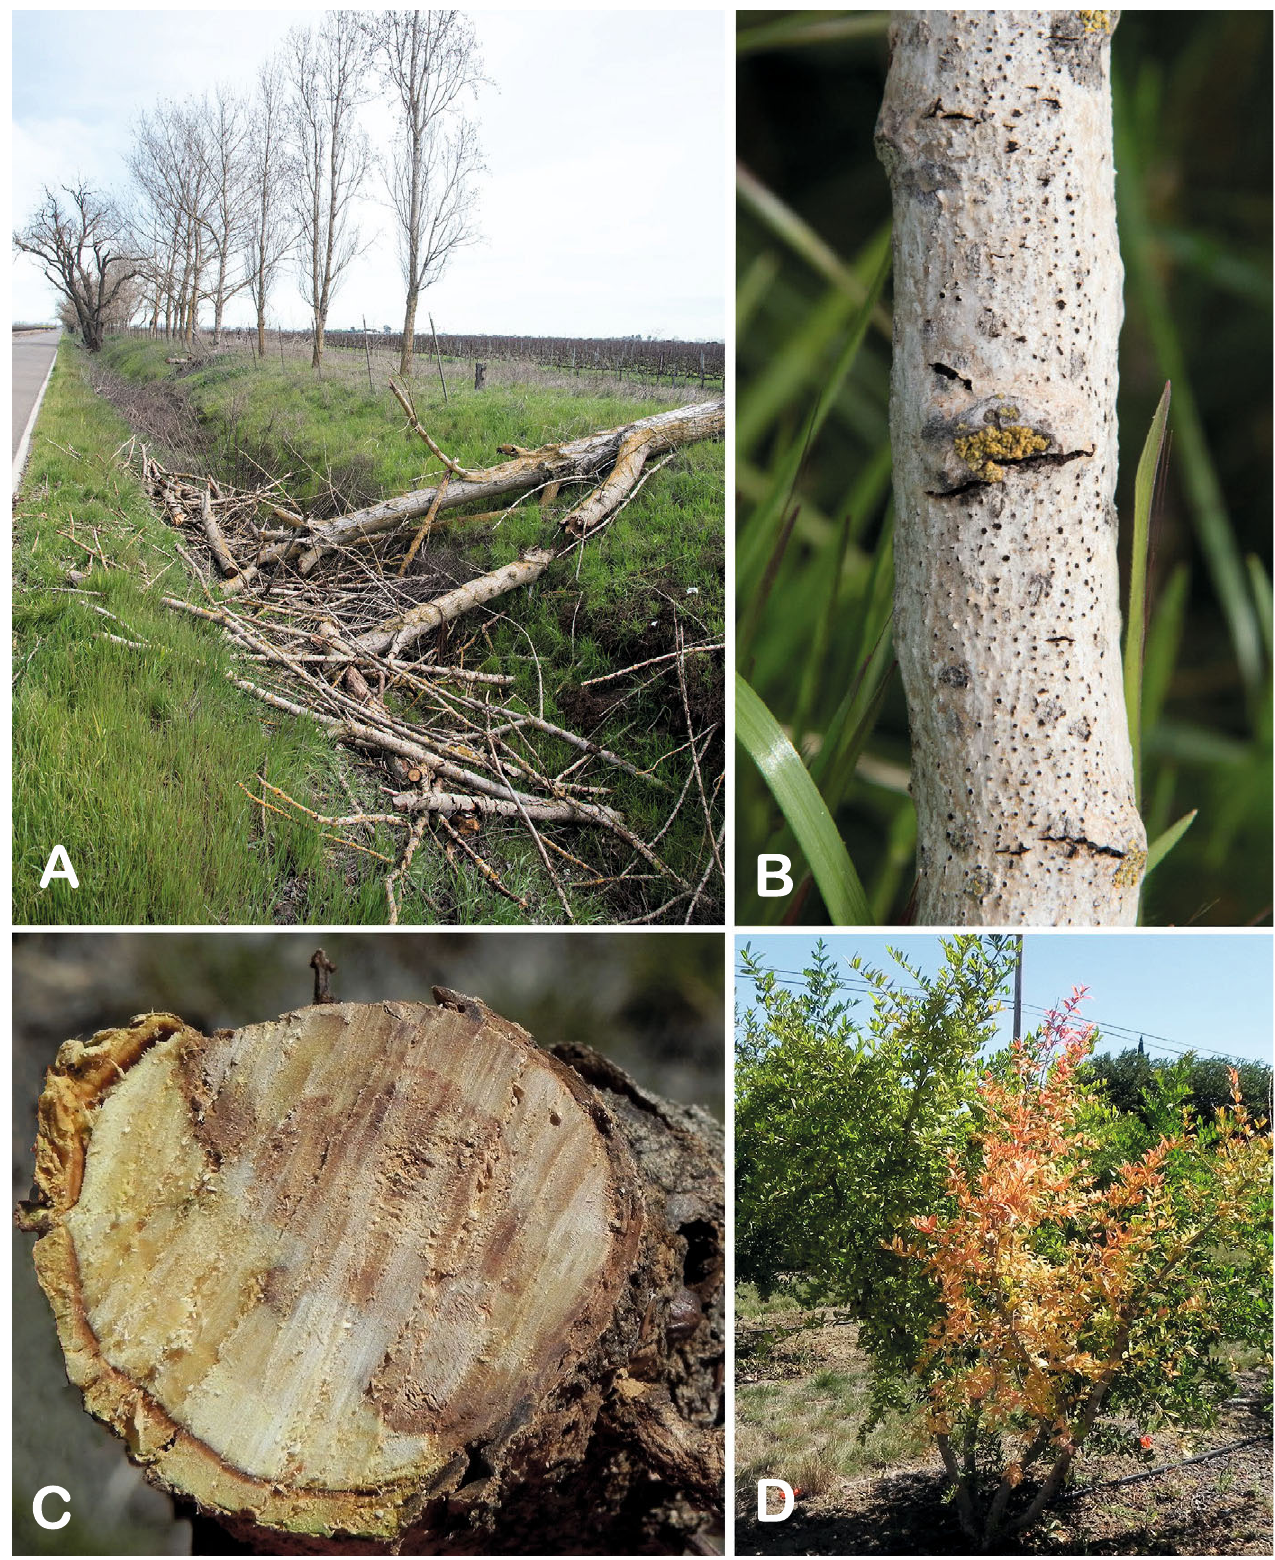
Fig. 3. Signs and symptoms of Cytospora canker/dieback in cottonwood and pomegranate hosts in California. (cid:7)(cid:4)(cid:8)(cid:6)(cid:2) Dead cottonwood tree parts on a roadside surrounding orchards and associated Cytospora asexual fruiting bodies erupting through the bark. (cid:2)(cid:9)(cid:4)(cid:10)(cid:6)(cid:2) Cytospora canker, wood discoloration and associated branch dieback in